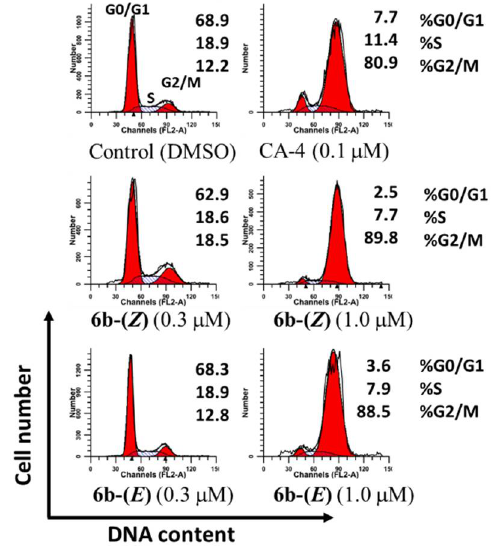
Figure 4. Analysis of cell cycle distribution in HepG-2 cells by flow cytometry. The cultured cells were treated with 6b-( Z ) , 6b-( E ) and CA-4 at the indicated concentrations for 24 h, then harvested, and analyzed using a FACS Calibur (BD Biosciences).